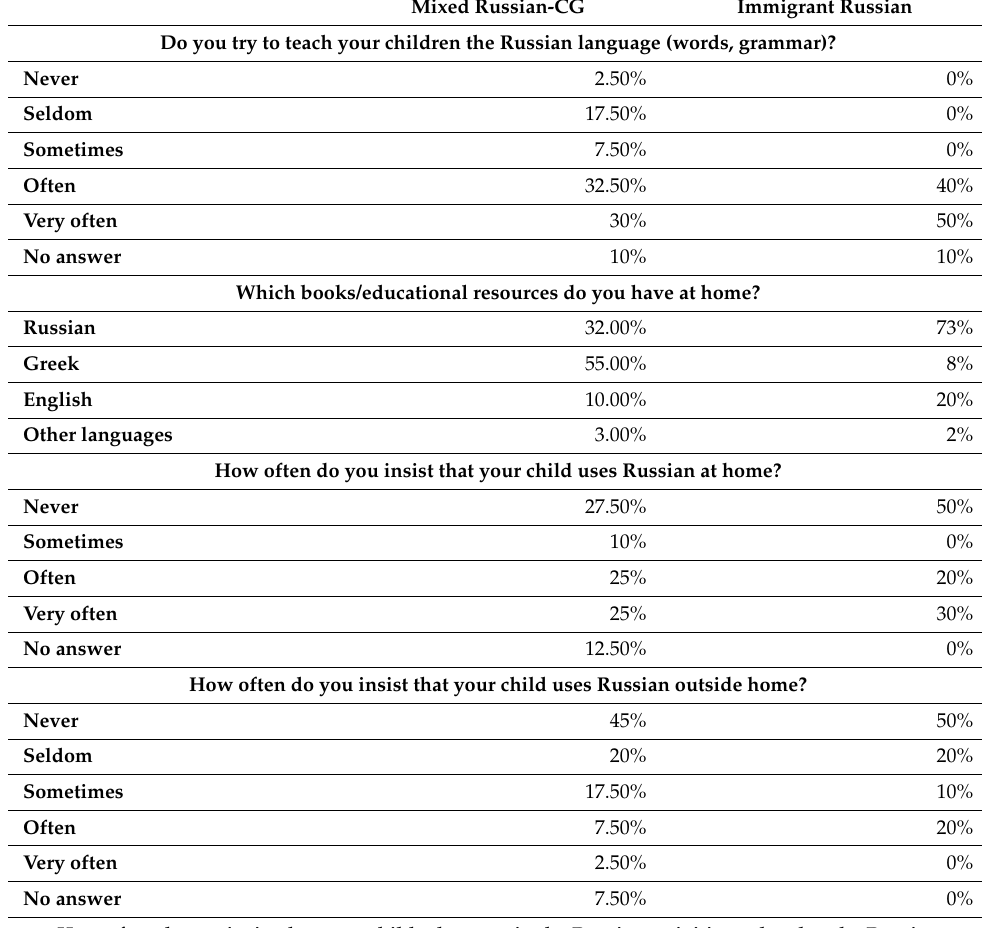
Table 4. Family type: HLE and literacy